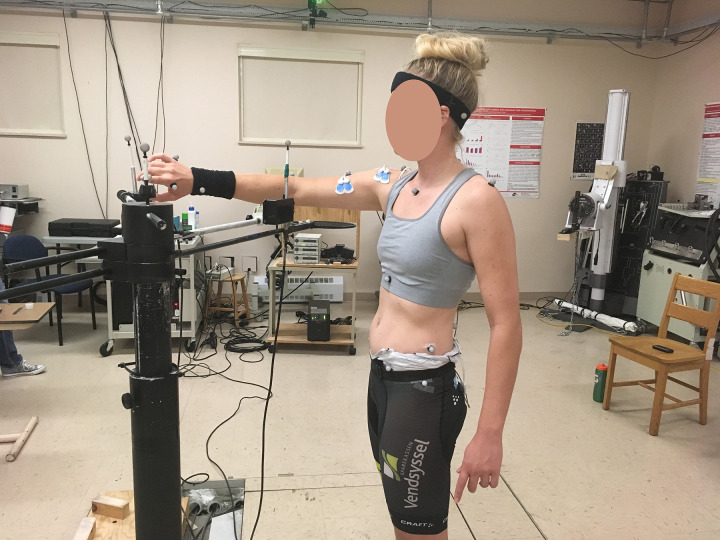
Experimental set-up for the repetitive pointing task.Note that in the present study, kinematics and pectoralis major EMG data were not collected.